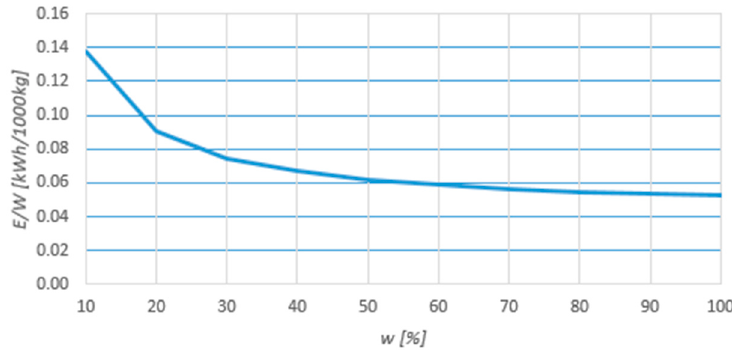
Figure 8. Unit electricity consumption as a function of efficiency [22].